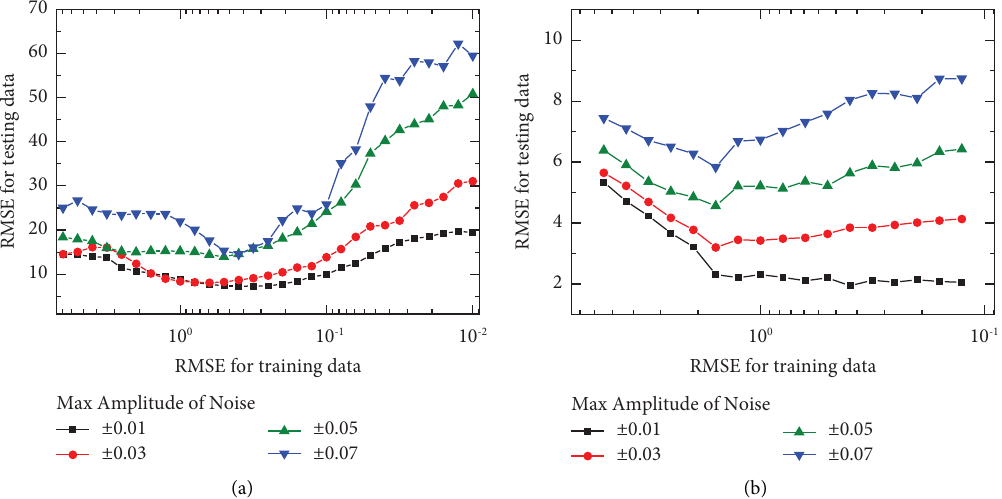
Figure 11: Testing RMSE vs. training RMSE by automatic scram prediction models with testing data containing artifcial noise: (a) a model based on the Elman neural network and (b) a model based on